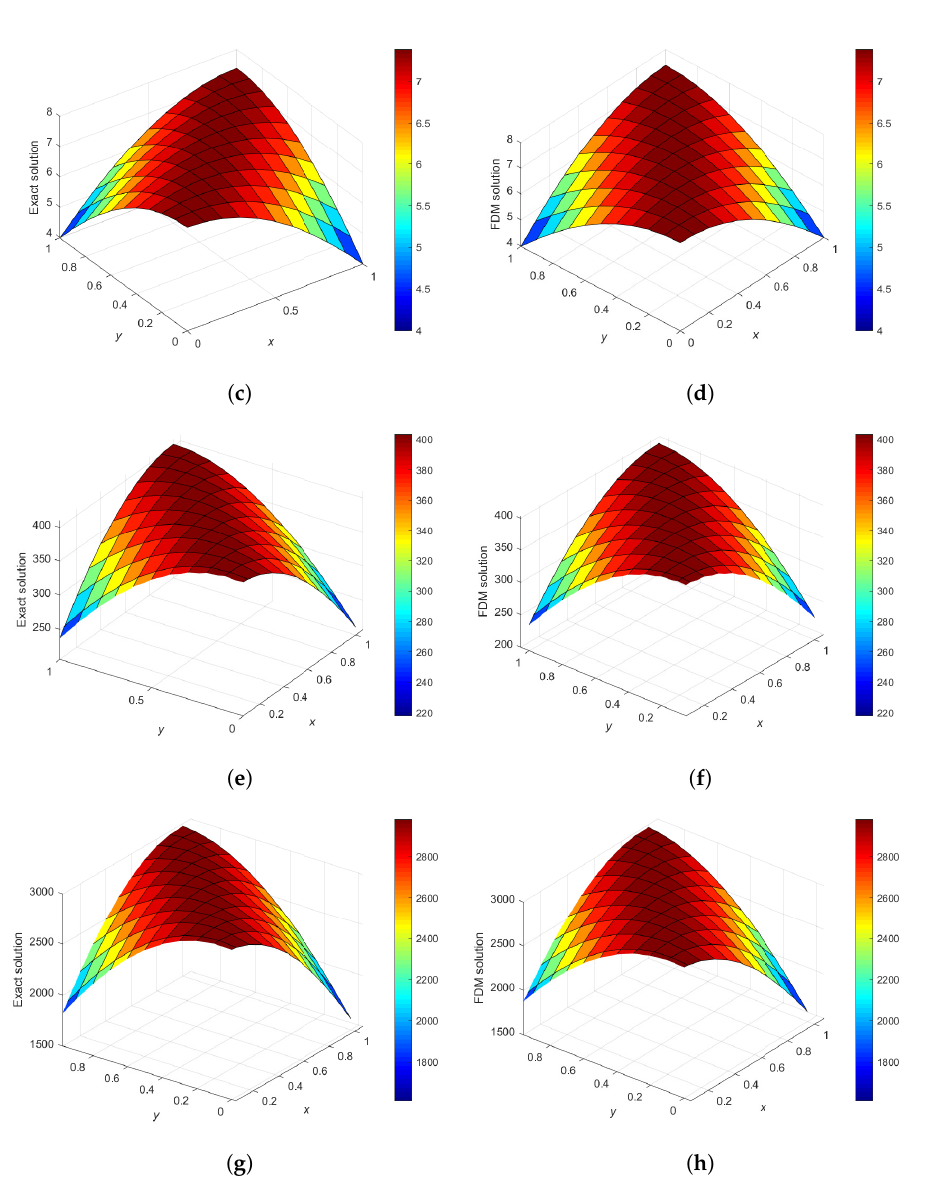
Figure 19. 3D plots of the exact and the FDM solution vs. x vs. y for ( x ; y ) ∈ Ω , Ω = ( 0,1 ) 2 ( ∆ t = 10 − 4 ) at times t = 1.0, 2.0, 5.0, 8.0. ( a ) ∆ t = 1.0 × 10 − 4 ,Time = 1.0; ( b ) ∆ t = 1.0 × 10 − 4 ,Time = 1.0;